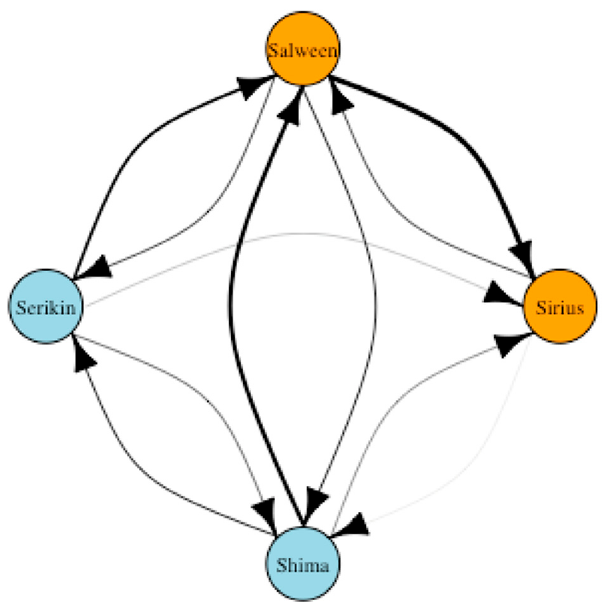
Figure 7. Sociogram displaying the frequency of affiliative interactions (directed) between the male, female, and cub tigers at Parc des Félins classed by age (orange = adult, light blue = cub). Edges are weighed based on total number of initiated interactions between two nodes.